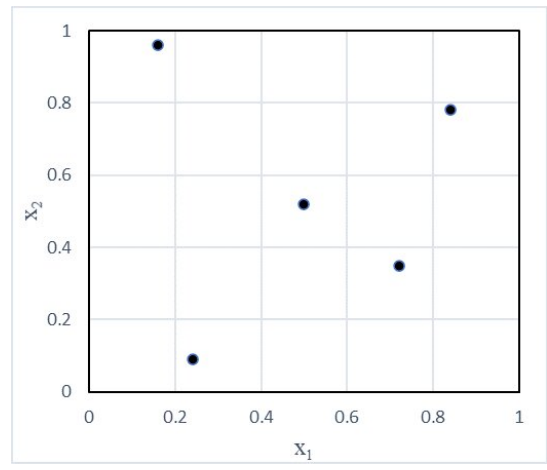
Figure 3 . Experimental design : Latin hypercube sampling . Figure 3. Experimental design: Latin hypercube